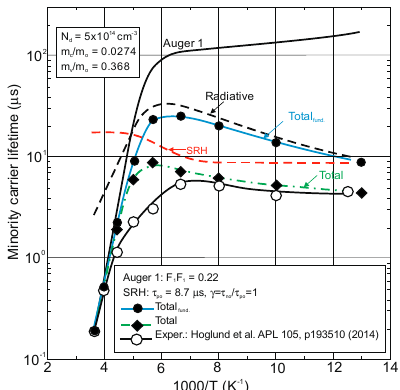
Figure 29. Hole minority carrier lifetime versus inverse temperature for a n-type MWIR InAs/InAs 0.54 Sb 0.46 T2SL with doping concentration 5 × 10 14 cm − 3 (after [114]).